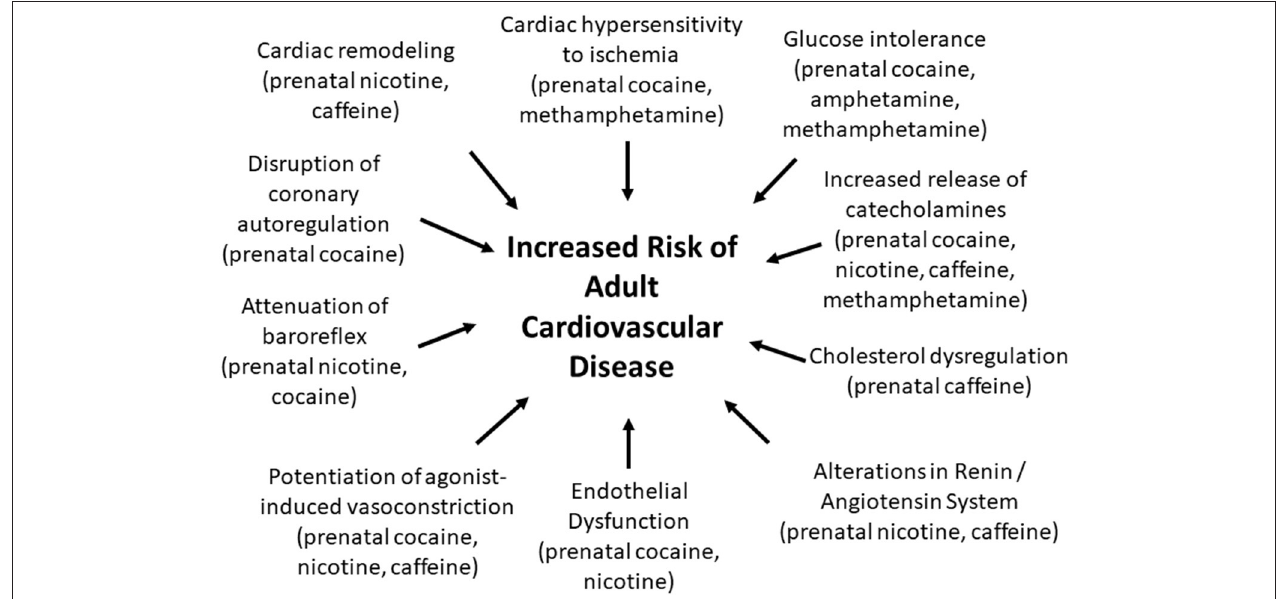
FIGURE 1 | Prenatal exposure to CNS stimulants induces changes in the adult offspring that may increase the risk for developing cardiovascular diseases.